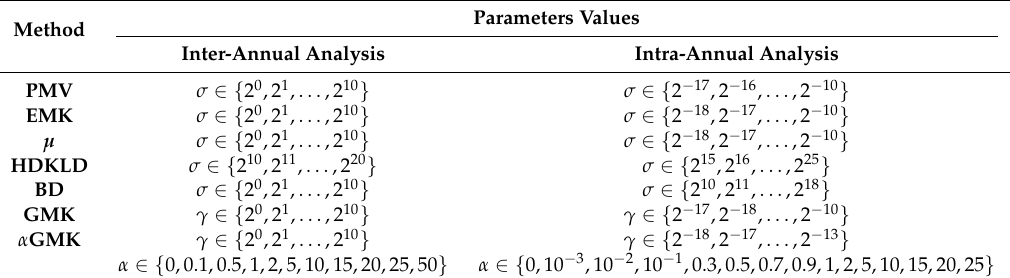
Table 4. Parameters tested for each method during